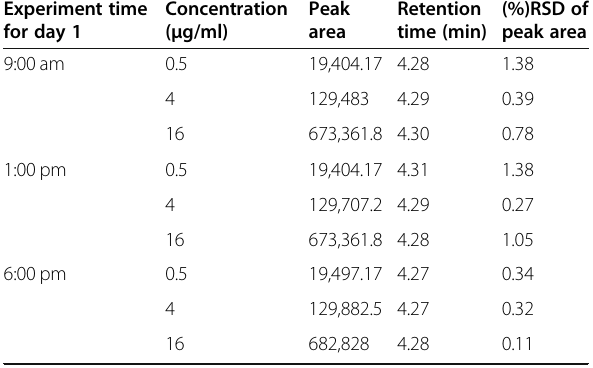
Table 6 Analysis of robustness and ruggedness using apigenin solution